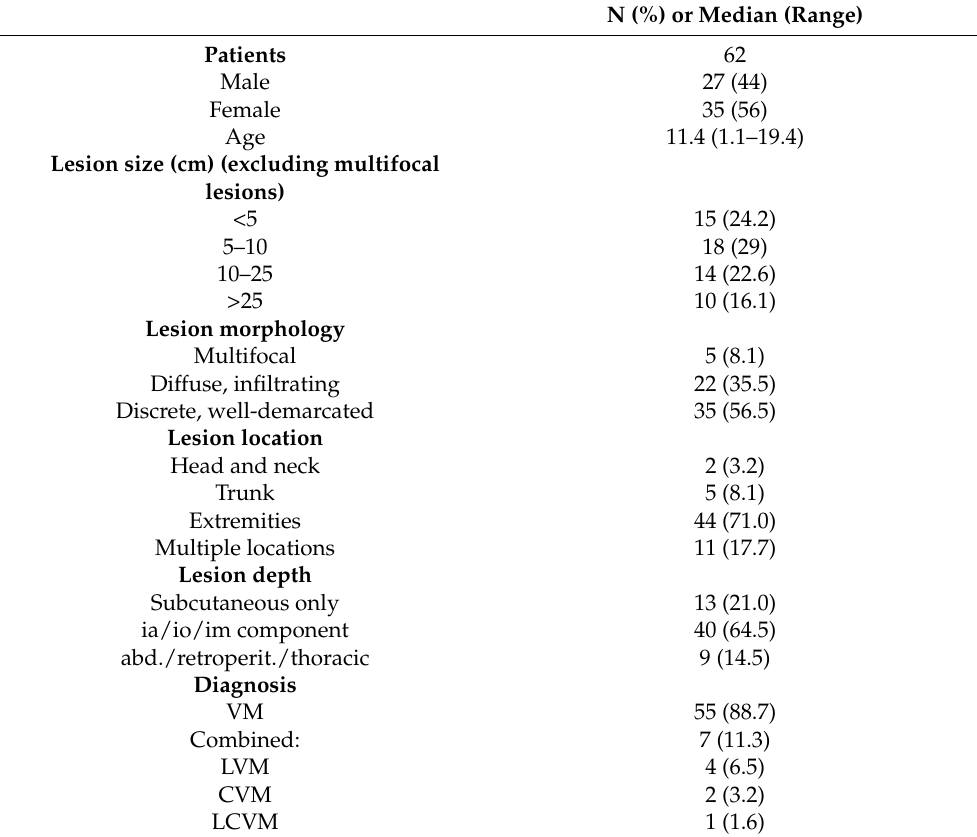
Table 1. Patient